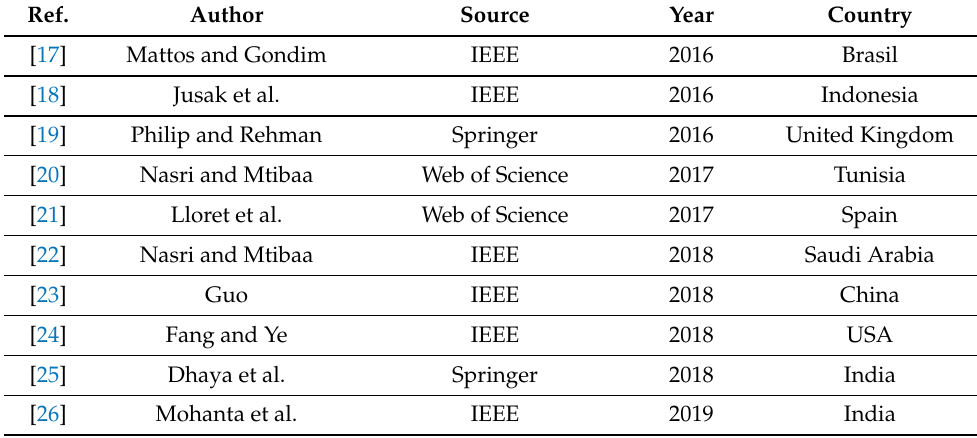
Table 1. Summary of articles included in the